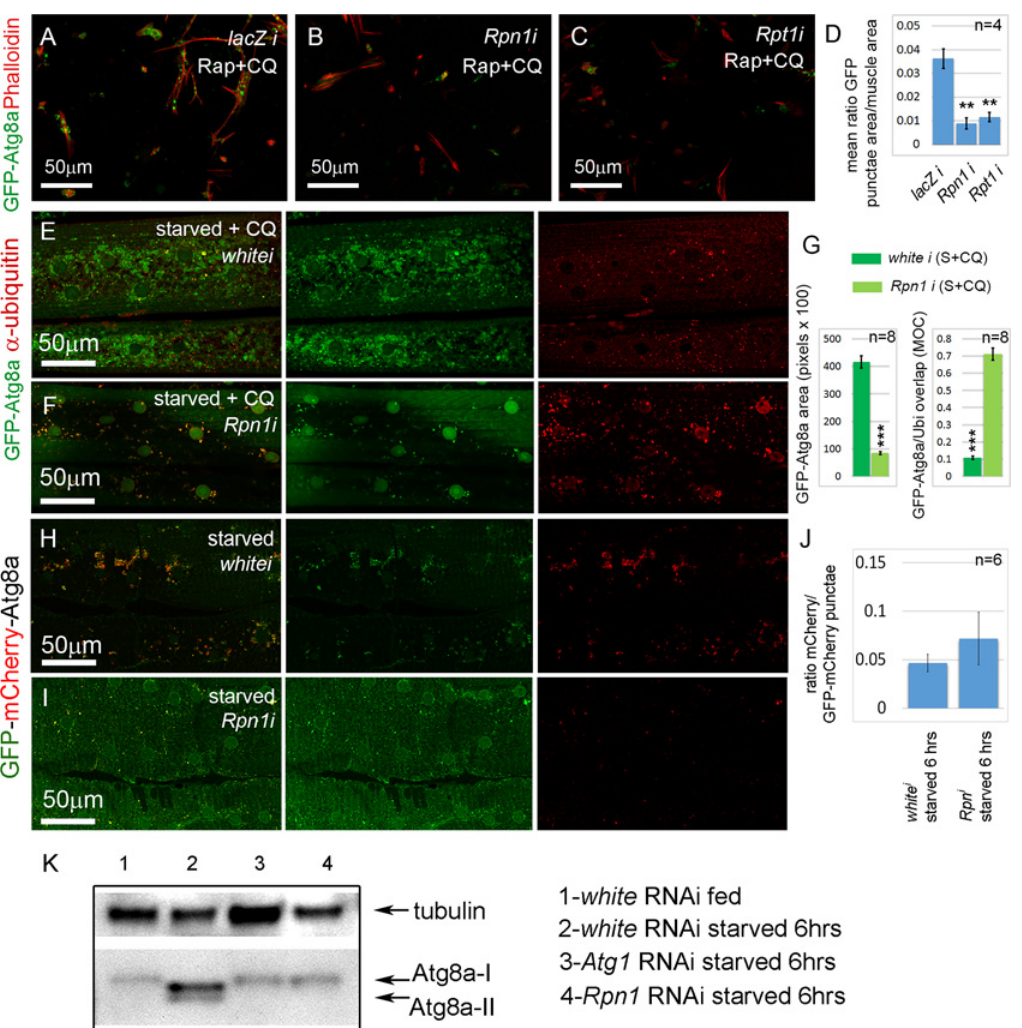
Fig 3. Sustained proteasome dysfunction inhibits autophagosome formation. (A) Primary cultured muscles with control lacZ RNAi, treated for 12 hrs with Rap+CQ. Note the formation of large GFP-Atg8a vesicles throughout the muscles. GFP-Atg8a vesicles are much reduced in primary cultured muscles with Rpn1 (PSMD2) RNAi (B) or Rpt1 (PSMC2) RNAi (C) , treated for 12 hrs with Rap+CQ. (D) Quantification for A-C of the mean ratio of GFP-Atg8a punctae area to total muscle area per well (n = 4). SEM is indicated with ** p < .01. (E) Control white RNAi muscles starved and treated with CQ accumulate GFP- Atg8a punctae, but very few colocalize with ubiquitin (Ubi). (F) Knockdown of Rpn1 in starved + CQ muscle strongly inhibits the formation of GFP-Atg8a punctae. The remainder colocalize with ubiquitin. (G) Quantification of the mean GFP-Atg8a punctae area and Mander ’ s overlap coefficient for GFP-Atg8a and Ubi for genotypes shown in E and F. Error bars indicate SEM for n = 8 ventral longitudinal muscles from individual animals, with p-values for Rpn1 RNAi relative to white RNAi control ( *** p < .001). (H, I) Autophagosome number is reduced, but autophagic flux is not significantly altered in starved Rpn1 vs. white RNAi muscles expressing GFP-mCherry-Atg8. (J) Flux measurement is shown on the right as the ratio of mCherry punctae to GFP-mCherry (n = 6). SEM is indicated. (K) Anti-Atg8a Western blot of third instar muscle lysate from Dmef2-Gal4; UAS-RNAi animals . In fed white RNAi control, endogenous Atg8a appears as a single band (Atg8a-I). 6 hrs starvation induces lipid modification of Atg8a and the appearance of a second band (Atg8a-II). Knockdown of Atg1 or Rpn1 inhibits Atg8a modification, indicating reduced autophagy levels. In all panels green = GFP-Atg8a. Red = Phalloidin (A-C), anti-ubiquitin (E, F), or mCherry (G,